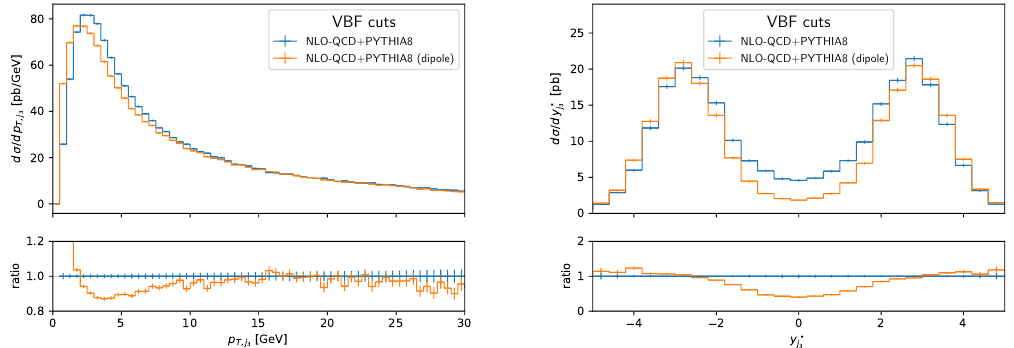
variable of the third-hardest jet jet 3